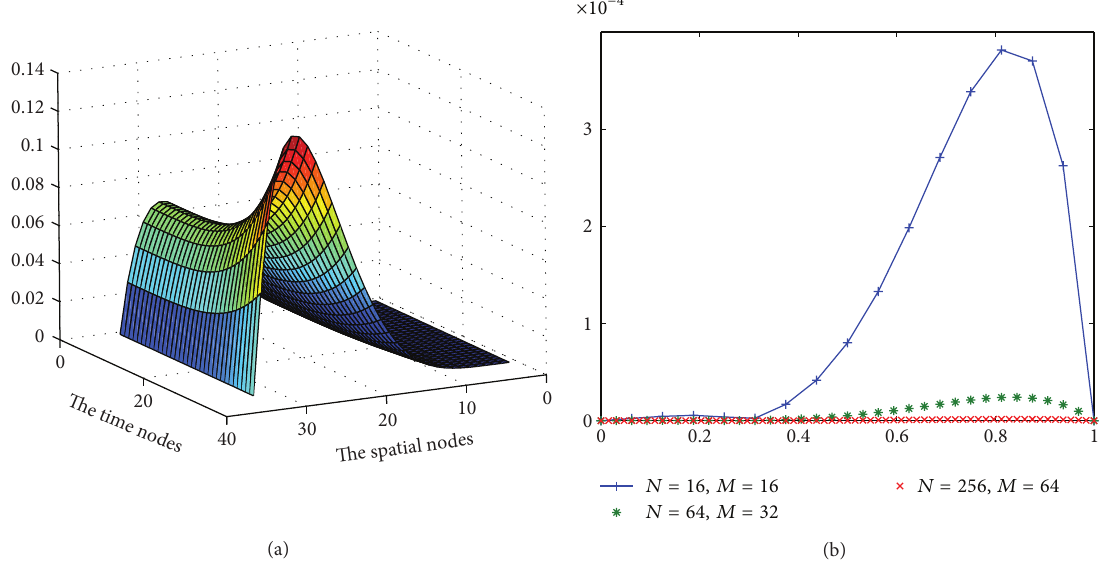
Figure 1: (a) The approximate solutions of Example 7 by the proposed method when 𝑁 = 32 , 𝑀 = 32 and 𝛼 = 0.5 . (b) The errors for some values of 𝑀 and 𝑁 when 𝑡 = 1 and 𝛼 = 0.5 .